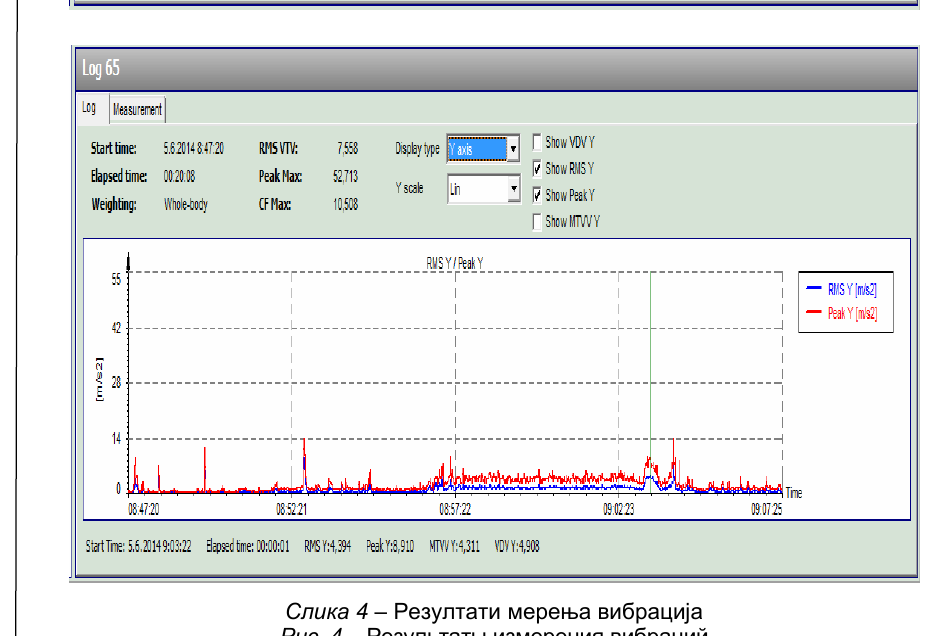
Figure 4 – Vibration measuring